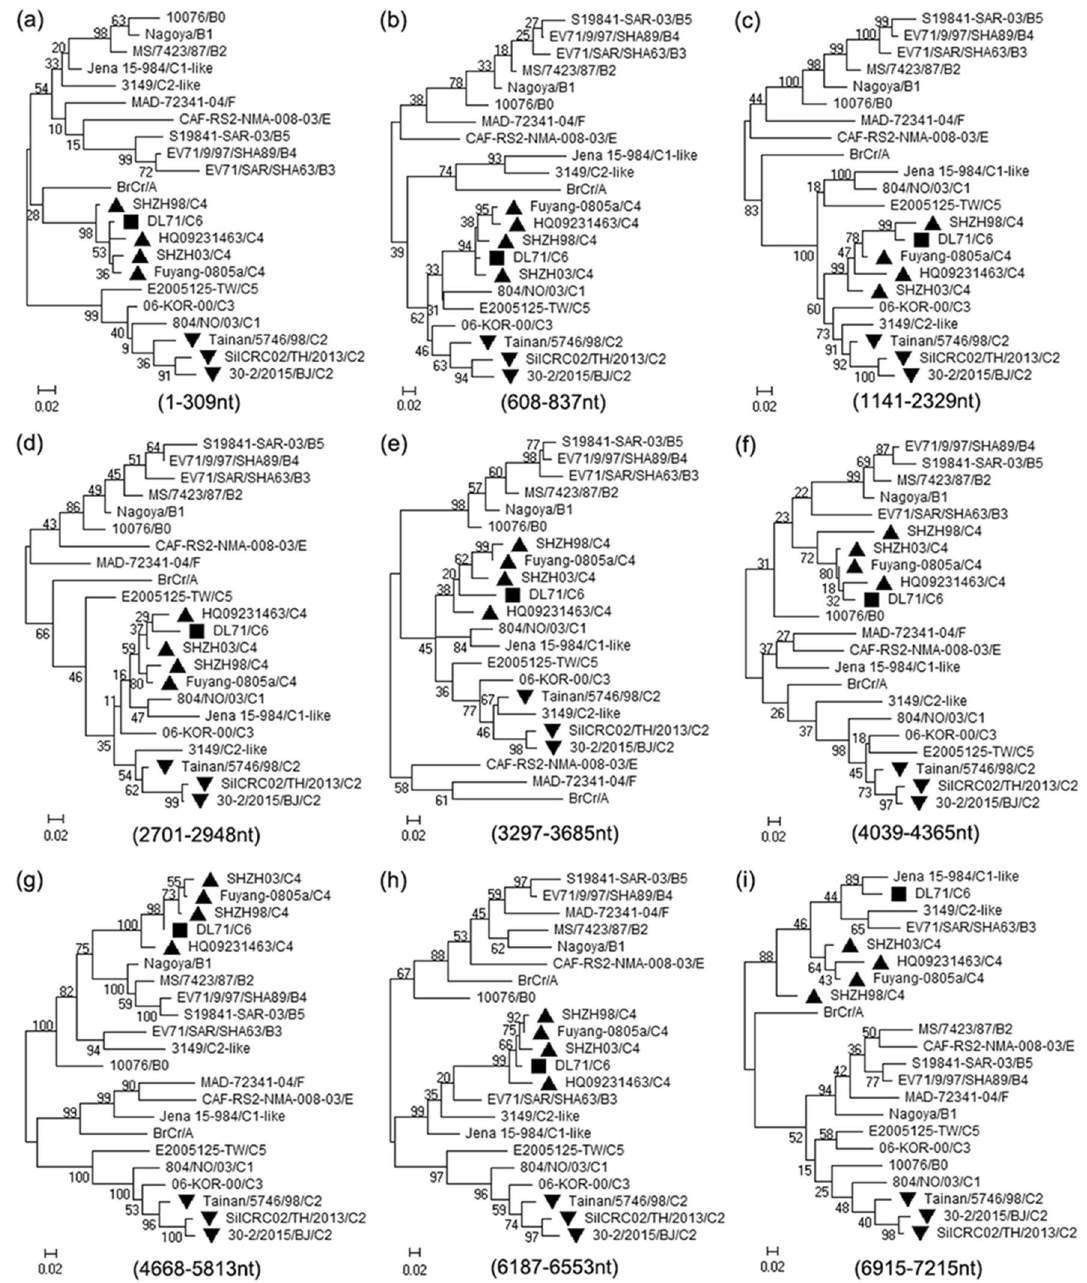
Figure 4. Phylogenetic trees based on the non-recombination regions of DL71. The regions ( a ) 1–309 bp, ( b ) 608–837 bp, ( c ) 1141–2329 bp, ( d ) 2701–2948 bp, ( e ) 3297–3685 bp, ( f ) 4039–4365 bp, ( g ) 4668–5813 bp, ( h ) 6187–6553 bp, and ( i ) 6915–7215 bp of DL71 and other reference strains were used to construct the phylogenetic trees by the maximum likelihood method with 1000 bootstrap replicates. The recombinant strain DL71 is labeled with a solid square (black filled square), the major parental strain with a solid regular triangle (black filled upward triangle), and the minor parental strain with a solid inverted triangle (black filled downward